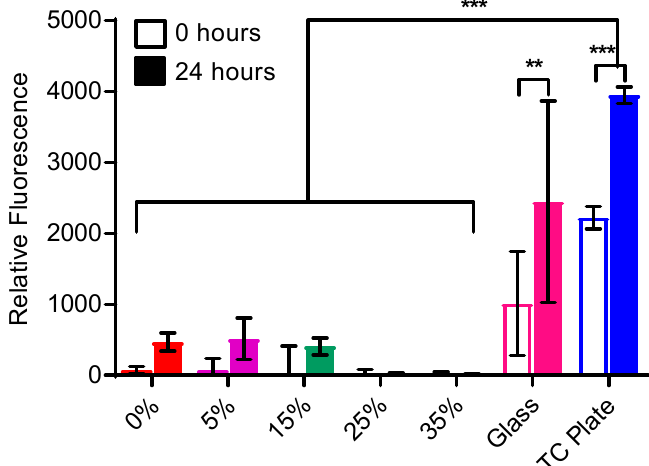
Figure 10. HaCaT cell metabolic activity on PHMB:PU membranes. Cell metabolic activity after 24 and 48 h using the Alamar blue assay on membranes which had been immersed in cell culture media overnight before cell seeding to mimic attachment after use in vivo. Tissue culture plate (TC plate) and glass were used as controls. Error bars describe the standard deviation from the mean, with n = 3. * indicates a significant di ff erence (** for p < 0.001; *** for p <